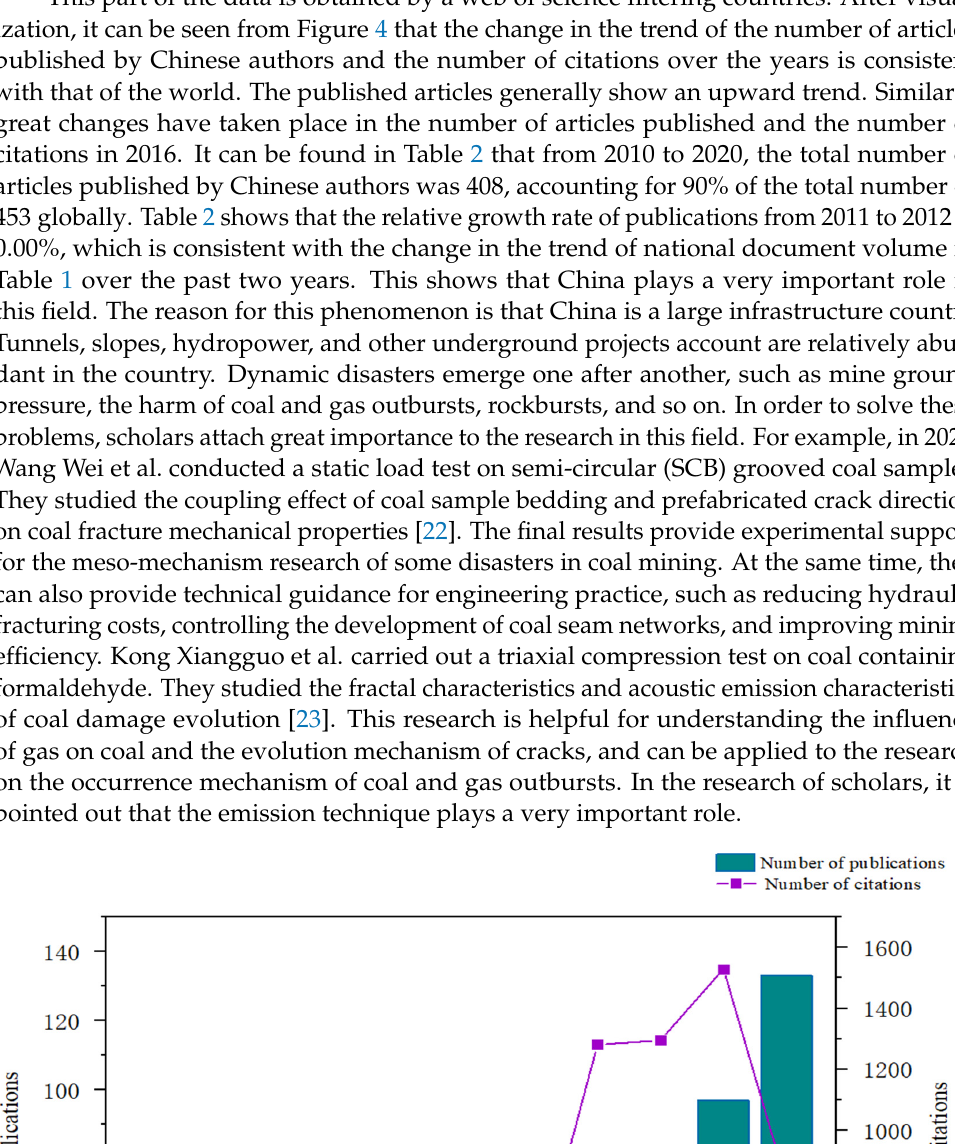
Table 2. Analysis, including the number of articles published by Chinese authors from 2010 to 2020.